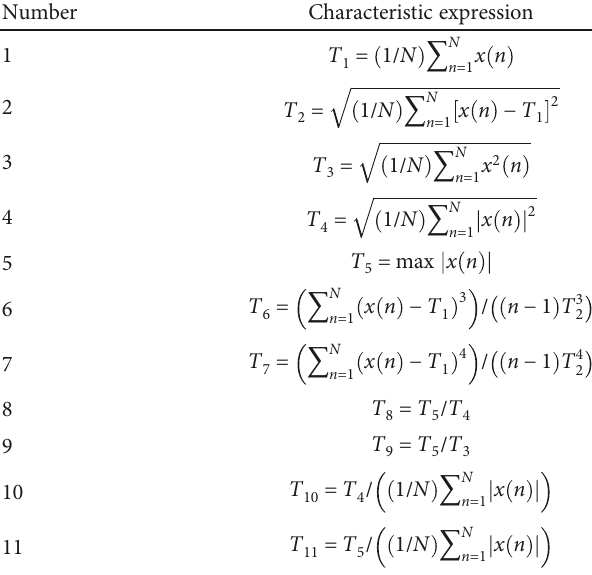
Table 2: Frequency domain characteristic parameters of vibration signal.